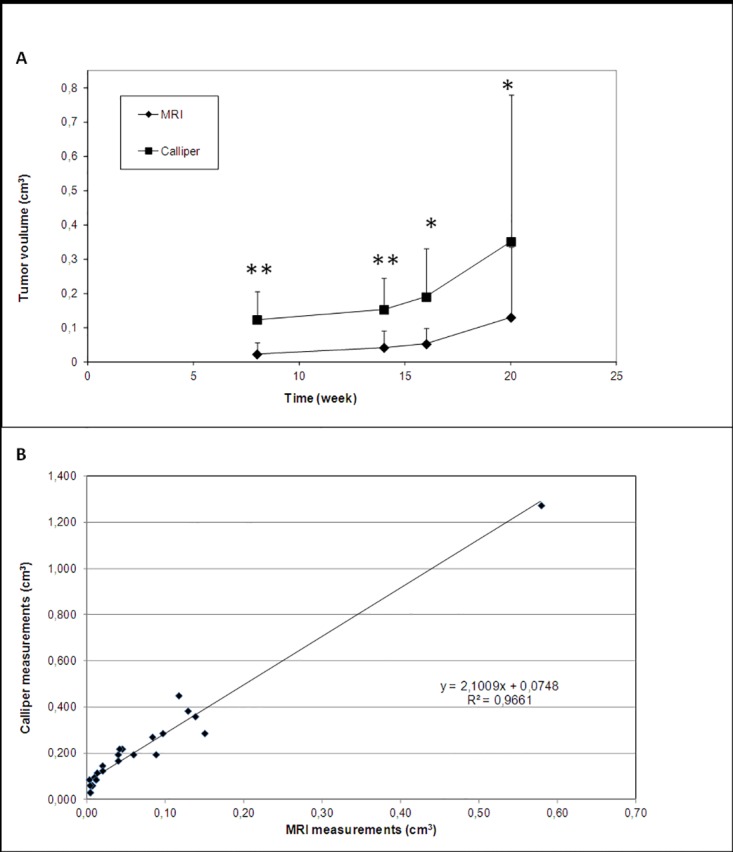
Tumor size over time.(A) Tumor growth profile measured by Caliper and MRI. Points, mean; bars, SD *p < 0.05, **p < 0.01. (B). Correlation between the two measurements, each point represents caliper measurement of tumor size (in cm3) plotted against MRI measurement of the same tumor specimen (n = 7), assessed 4 times over 20 weeks.